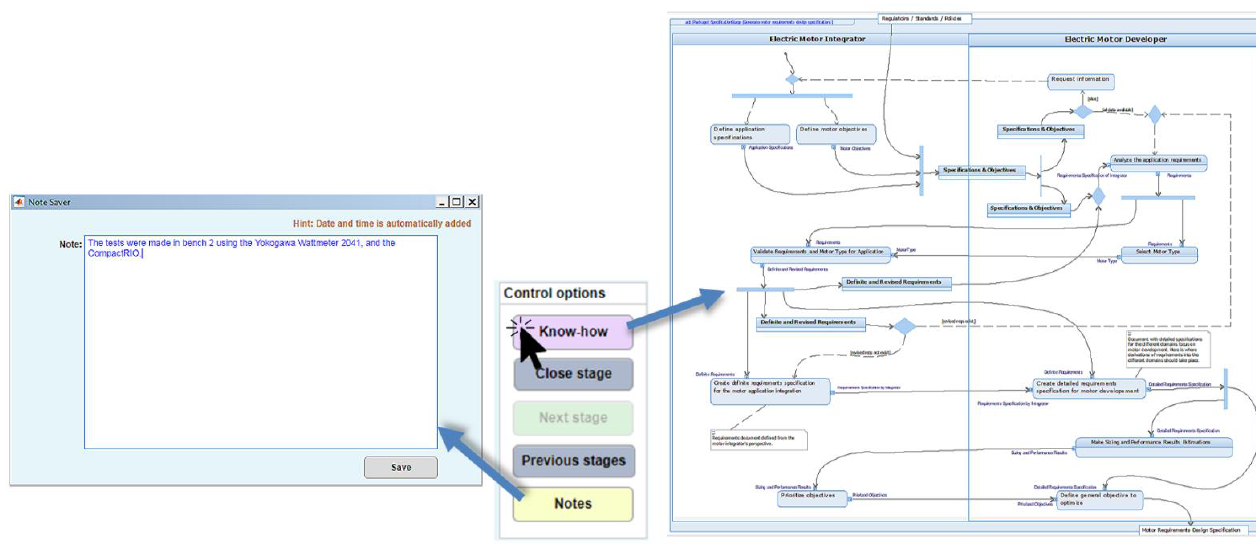
Figure 12. Illustration of know-how retrieval and note creation.